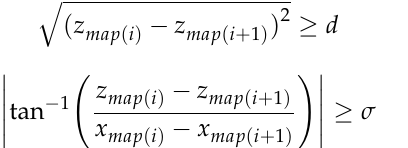
Figure 6. The 3D road map.